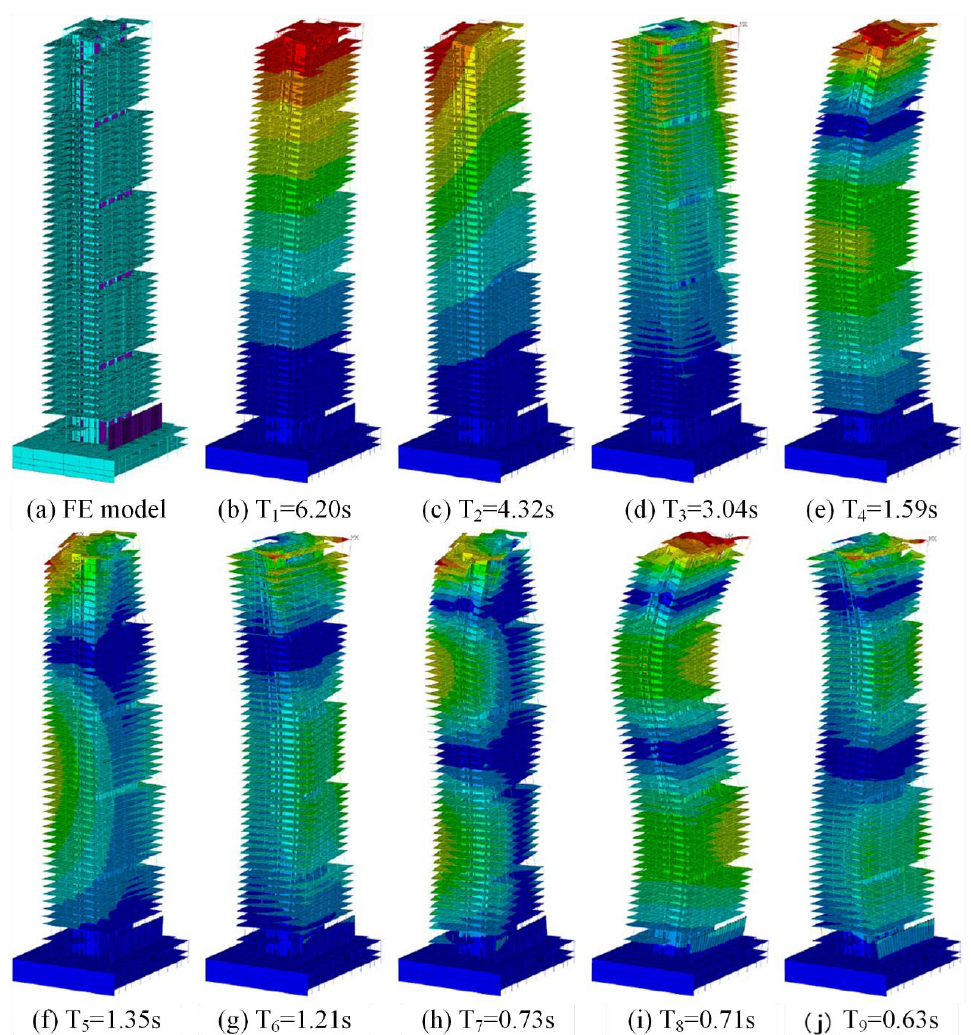
Figure 8. FE model and former nine modes of the LGCW with the high-rise